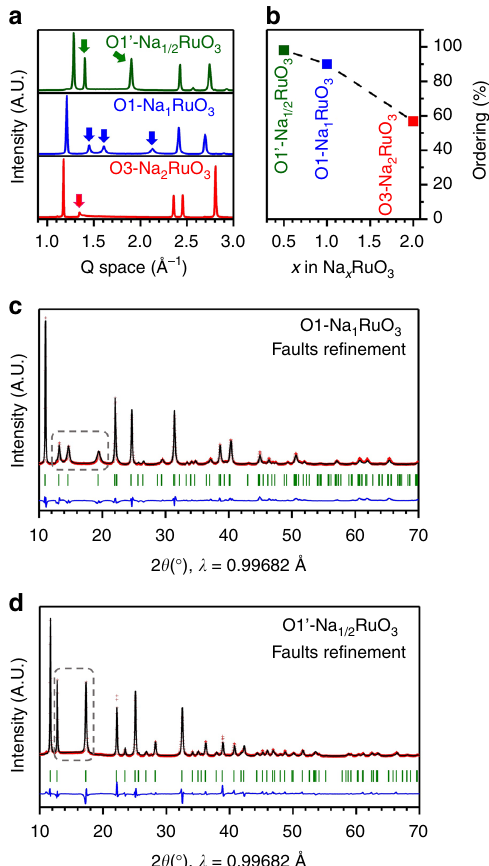
Fig. 3 Progressive stacking-fault-depression (self-ordering) upon charging Na 2 RuO 3 . a Synchrotron XRD patterns of O3-Na 2 RuO 3 , O1-Na 1 RuO 3 and O1 ′ -Na 1/2 RuO 3 . Arrows indicate the most intense superstructure peaks. b Evolution of the ordered stacking (absence of stacking faults) as a function of the Na content. The error bars are smaller than the mark size. c , d Observed and calculated (FAULTS re fi nement) synchrotron XRD patterns of O1-Na 1 RuO 3 and O1 ′ -Na 1/2 RuO 3 , respectively. Red crosses: experimental, black line: calculated, blue line: difference plot and green bars: Bragg positions in the R (cid:1) 3:h and P (cid:1) 31 m space groups for O1-Na 1 RuO 3 and O1 ′ -Na 1/2 RuO 3 , respectively. The dashed rectangles indicate the most intense superstructure